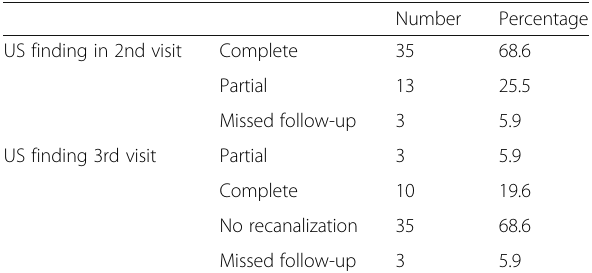
Table 7 The ultrasound follow-up findings in the 2nd and 3rd visits